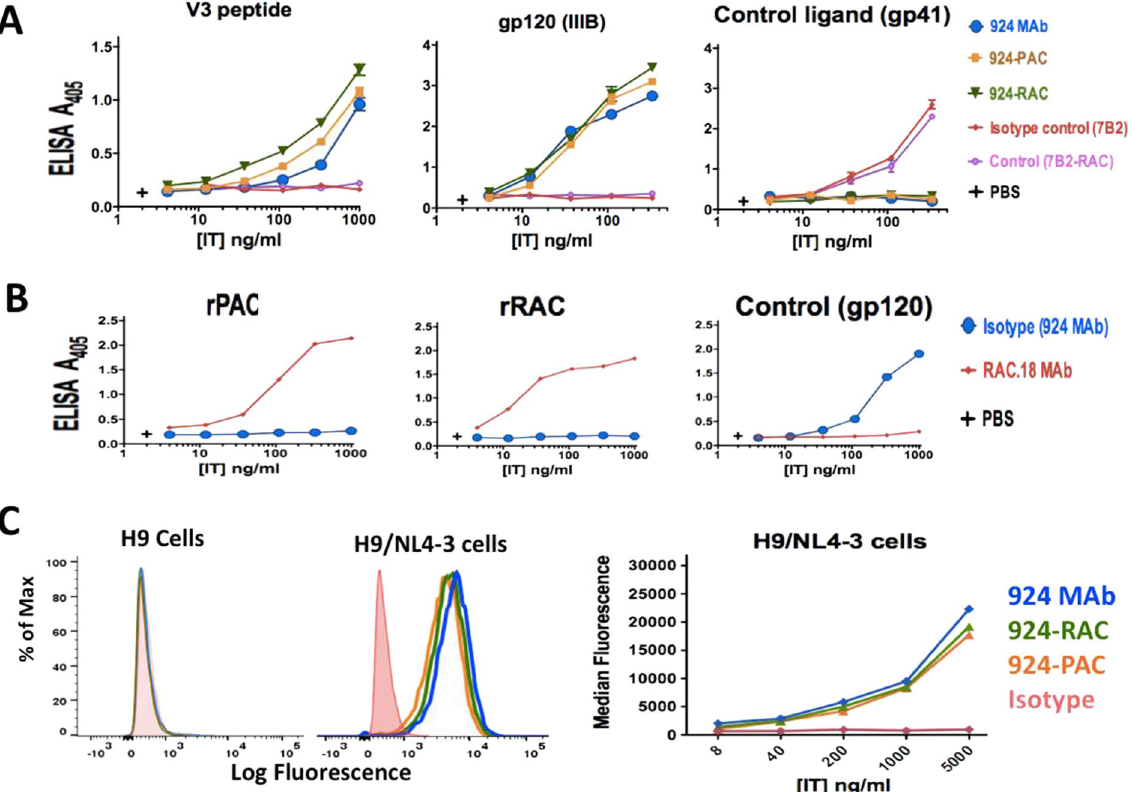
Figure 2. 924 based-ITs bind to recombinant antigens and native antigens on the HIV infected cells. ( A ) ELISA plates are coated with a synthetic V3 loop peptide, recombinant gp120 and gp41 peptide as a control ligand. The results show the binding of 924 MAb and 924-ICs to the either gp120 or V3 peptide, but not the unrelated isotype controls. ( B ) ELISA plates are coated with recombinant RAC, PAC and recombinant gp120 as a control ligand. The results demonstrate the binding of anti-ricin A chain MAb (RAC18) to rPAC and rRAC, but not the unrelated isotype control. In panels ( A and B ) the Ab binding is detected with AP-conjugated goat anti- mouse IgG. Where no error bars are visible they are obscured by the symbol. Results are representative of means of duplicate values with at least three different assays (varying by Ab, ITs, or Ag tested). ( C ) Flow cytometry histograms for binding of 924 MAb and 924 based-ITs to uninfected H9 cells, as control, and persistently- infected H9/NL4-3 cells. Binding was detected with Alexa488 conjugated goat anti-mouse IgG. On the right, IT binding to H9/NL4-3 cells is plotted as median fluorescence versus IT concentration. The results are representative of three independent experiments. Isotype control is shown as red shaded